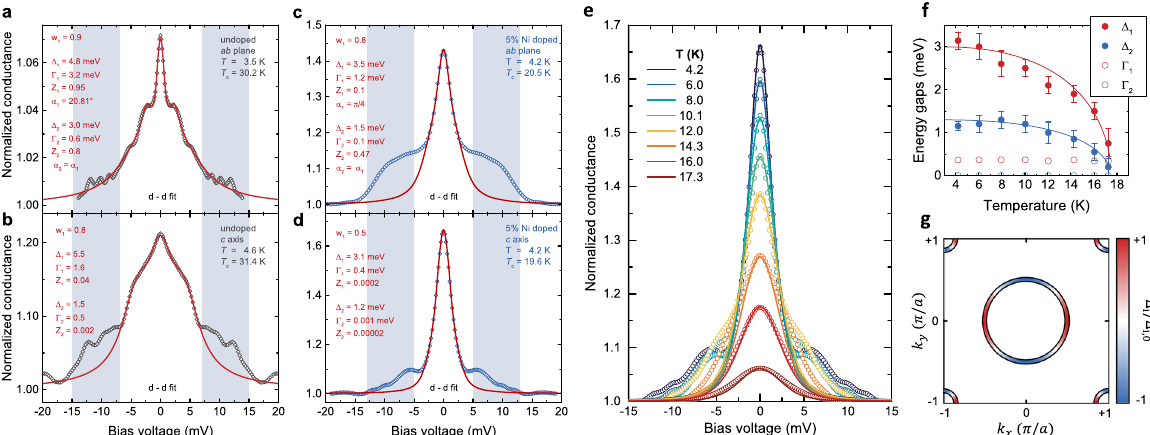
Fig. 2 PCARS spectra and superconducting gap symmetry of Rb-12442. Representative low- T directional PCARS spectra (symbols) on single crystals of RbCa 2 (Fe 1 − x Ni x ) 4 As 4 F 2 with x = 0 ( a , b ) and x = 0.05 ( c , d ), and corresponding two-gap fi ts of the spectra in a d − d model (solid red lines). The fi tting parameters are indicated in labels. e Temperature dependence of the PCARS spectra (symbols) and corresponding d − d fi ts (solid lines) for the same contact shown in d . f Superconducting energy gaps ( fi lled circles) and broadening parameters (hollow circles) as a function of temperature, determined by fi tting the spectra shown in e with the d − d model. Error bars represent the interval of gap values obtained with different normalizations of the same curve, as explained in the Methods, and include the uncertainty due to the fi t. Solid lines are the expected BCS dependencies. g Scheme of the gap structure (normalized gap values as color scale) showing the compatibility of the d − d symmetry with the underlying Fermi surface